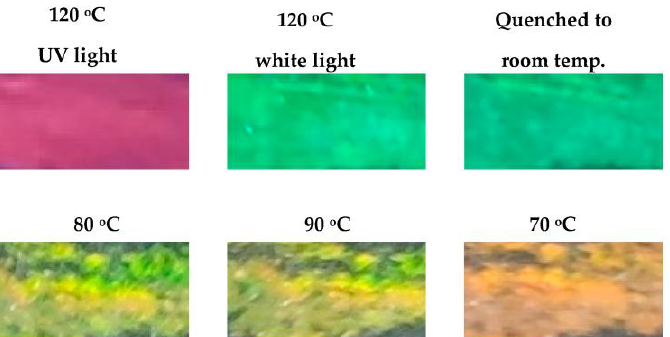
Figure 4. Photographs of the mixture film prepared by the Dr. Blade technique at 120 ◦ C taken under the UV light and daylight at different temperatures. The sample was quenched or slowly cooled down (1 ◦ C/min). Photographs were taken under oblique viewing (40–60 ◦ ). The width of the image is ca. 5 mm.